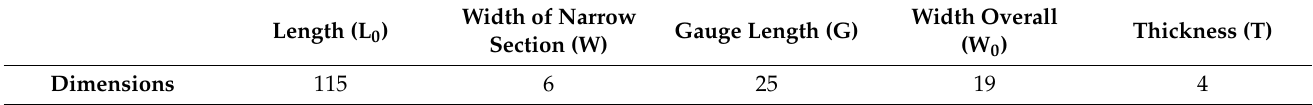
Table 3. Dimensions of tensile samples (units: mm).